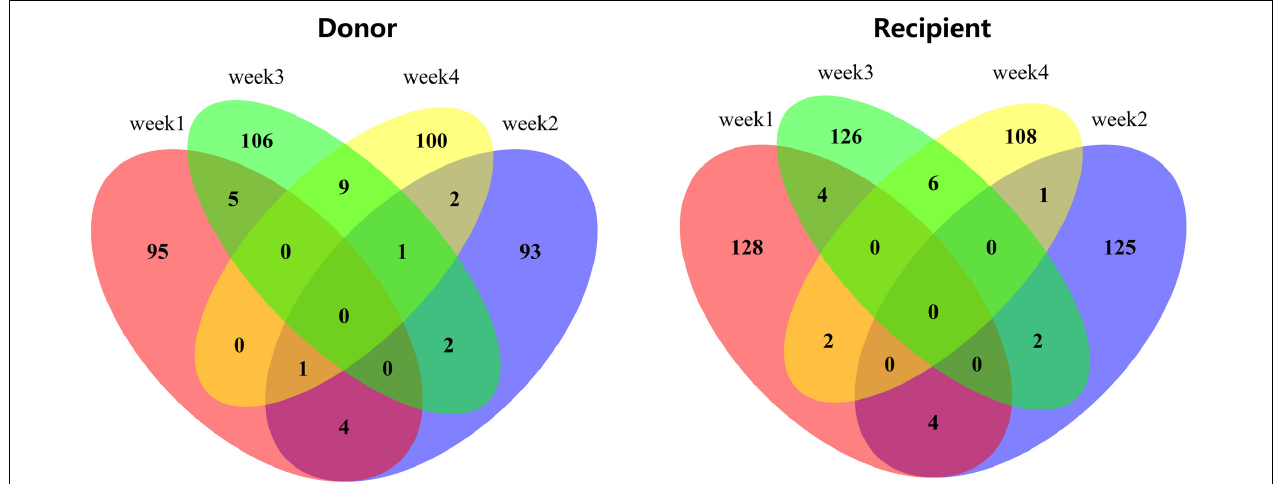
FIGURE 3 | Venn diagram showed the correlation between week1 and week2 (convalescence phase), as well as week3 and week4(stabilizing phase) in donors and recipients respectively. The numbers meant the number of intersections between or among weeks. 0 meant no intersection. TABLE 2 | Univariate and multivariate regression analysis in convalescence phase. Univariate Multivariate Bootstrap